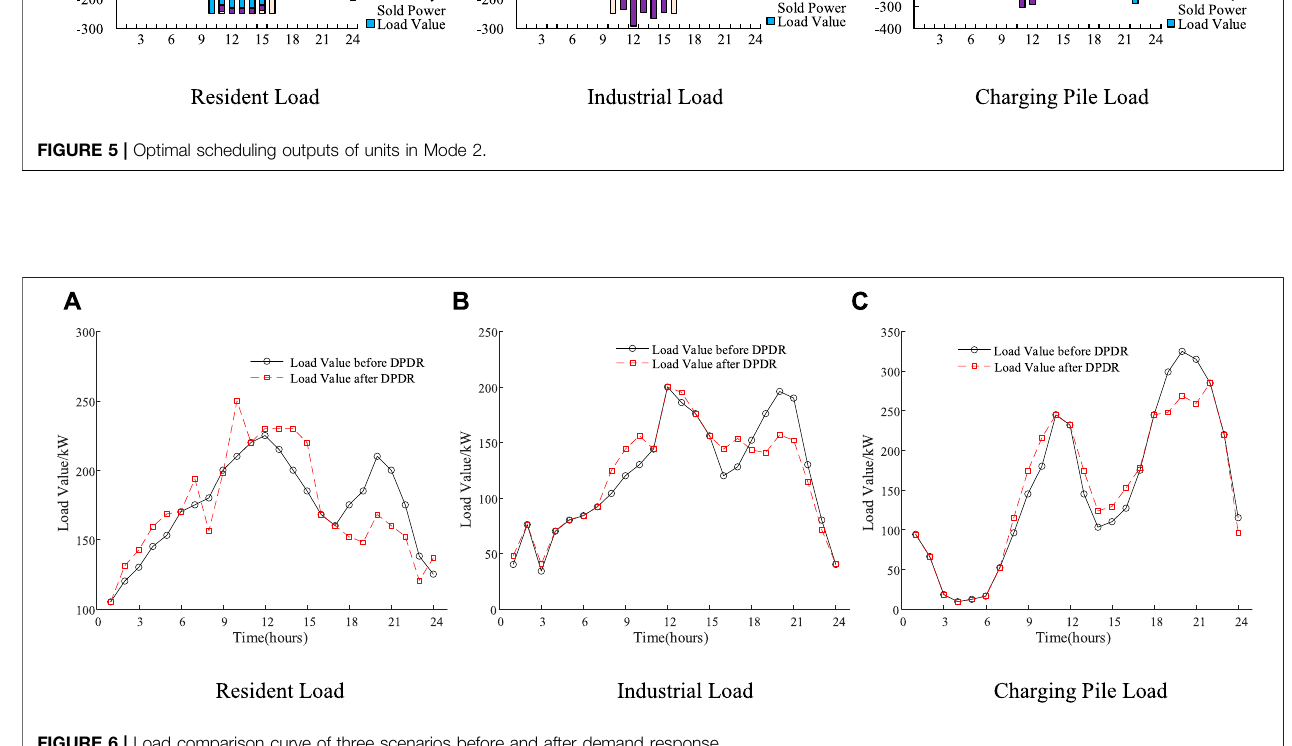
FIGURE 6 | Load comparison curve of three scenarios before and after demand response.